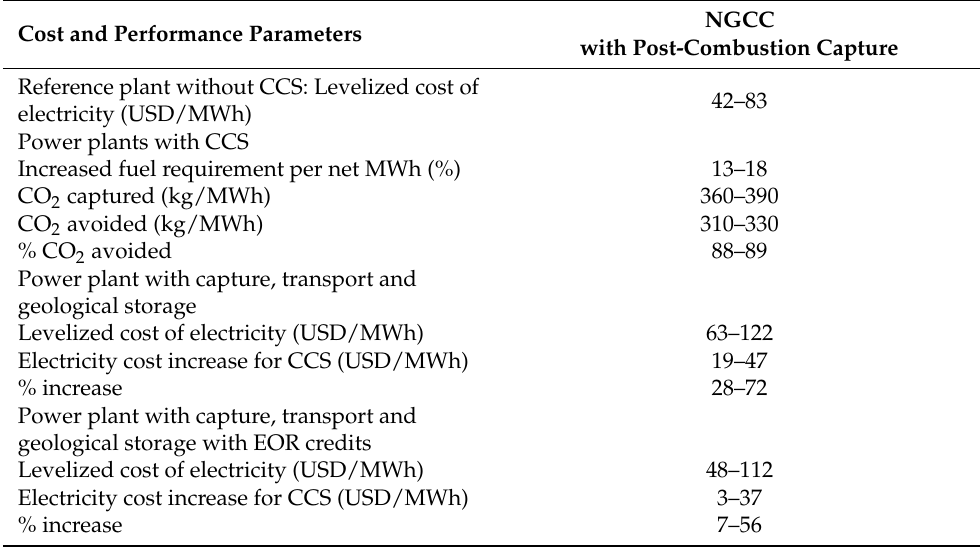
Table 14. Range of total costs for CC, transport and geological storage (2013 USD) (adapted from [35]). Cost and Performance Parameters